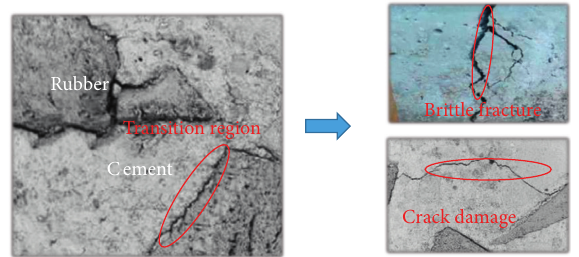
Figure 2: Electron microscopic picture of the interface transition zone and macroscopic failure